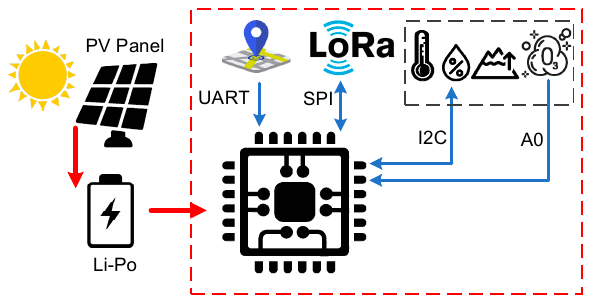
Figure 4. Proposed MSMN architecture.